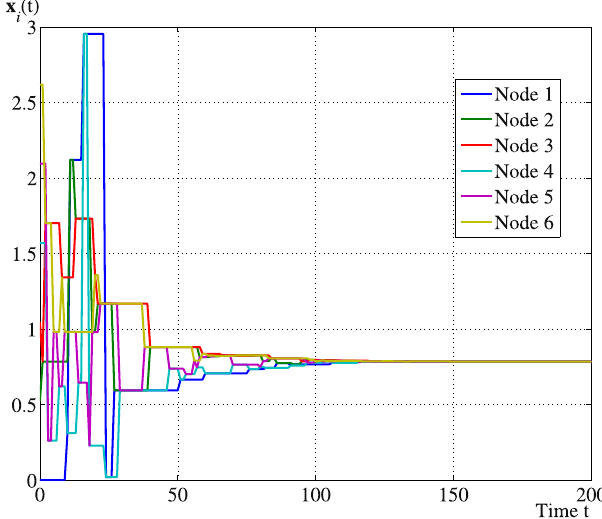
Figure 2. A sample path of x i ( t ), = …